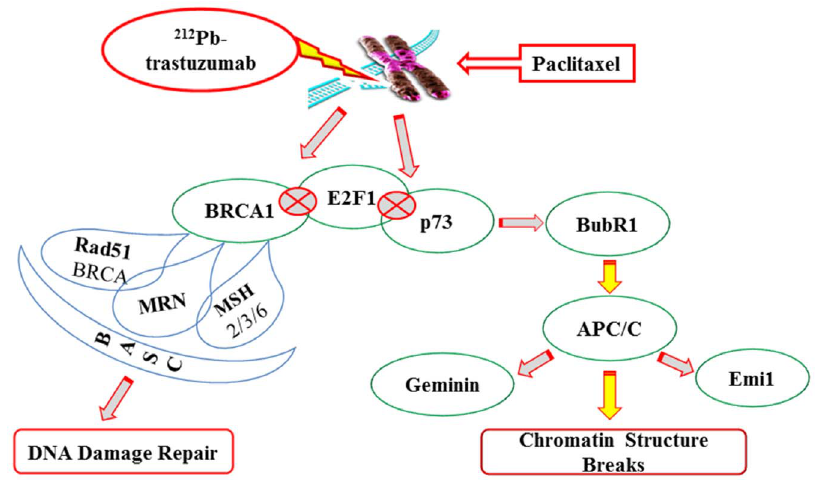
Figure 3. Proposed mode of action in the induction of chromosomal instability by Pac/ 212 Pb-trastuzumab treatment. See text for details.